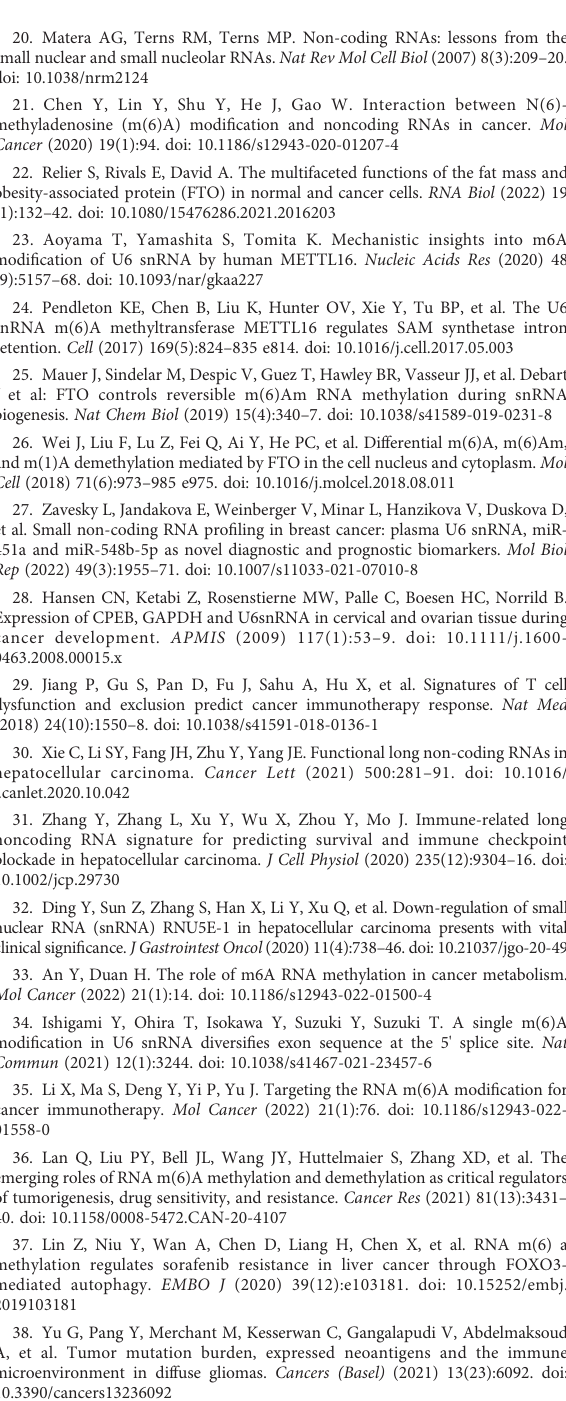
SUPPLEMENTARY FIGURE 2 Kaplan-Meier curve analysis of OS in male low- and high-risk HCC patients on clinicopathological characteristics (including age, grade, and TNM